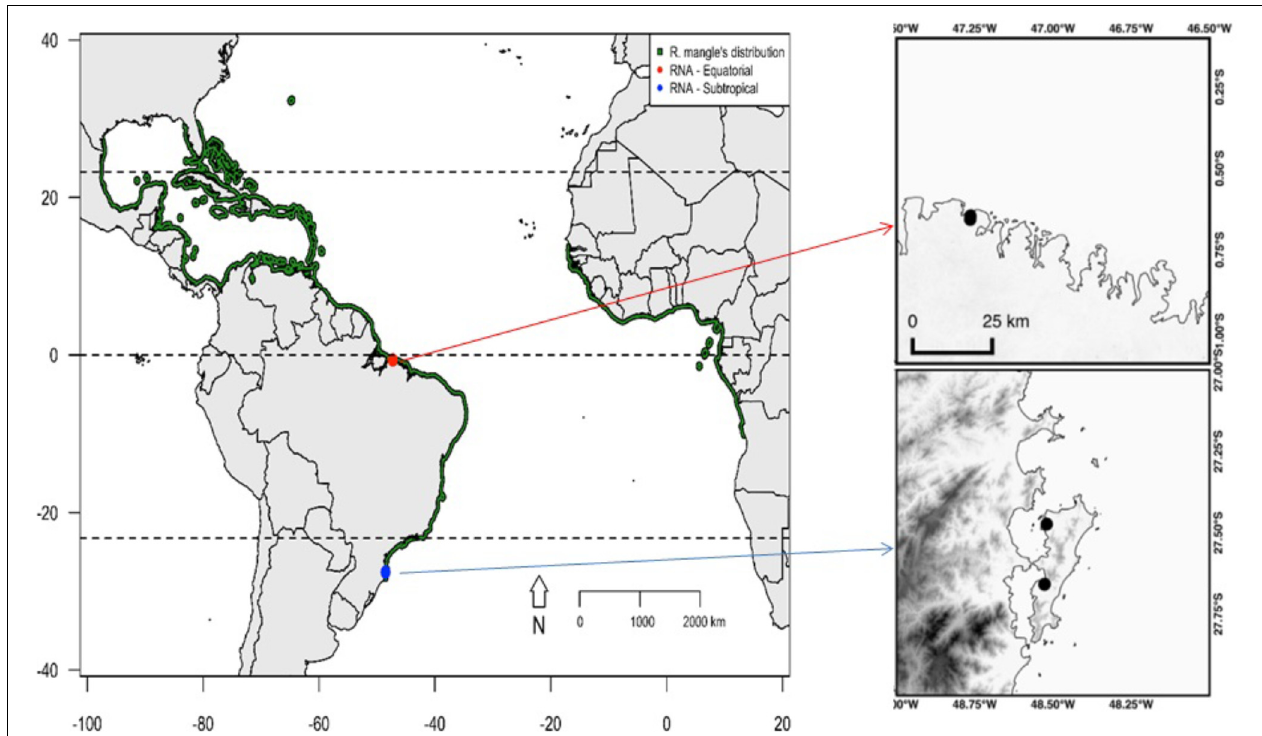
FIGURE 1 | The distribution of Rhizophora mangle is indicated in green. Points represent the two plant material sampling sites. The red point represents the sampling site for the three plants in the equatorial region, and the blue point represents the sampling site for the three plants at the far southern end of the distribution of the